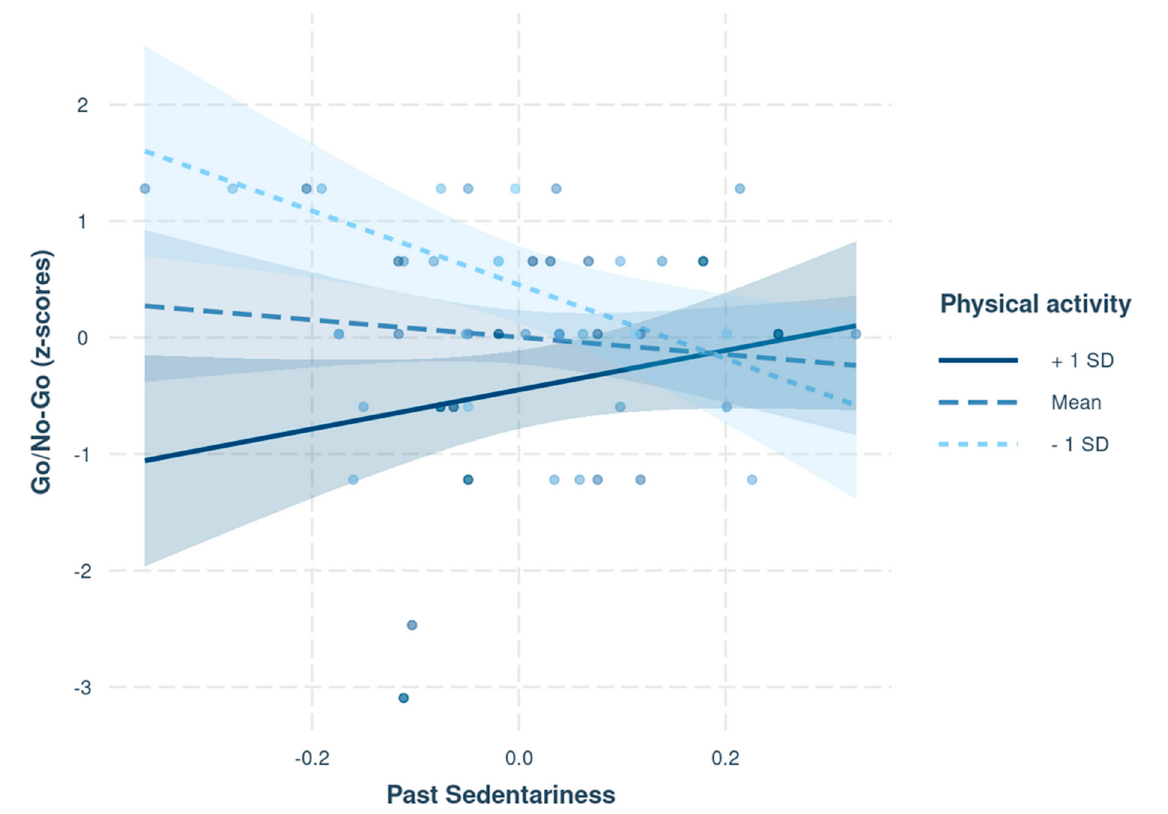
Figure 2. Prediction of z-scores for cognitive inhibition (“Go/No-Go” test) according to past sedentariness for different levels of physical activity (average, low, and high).